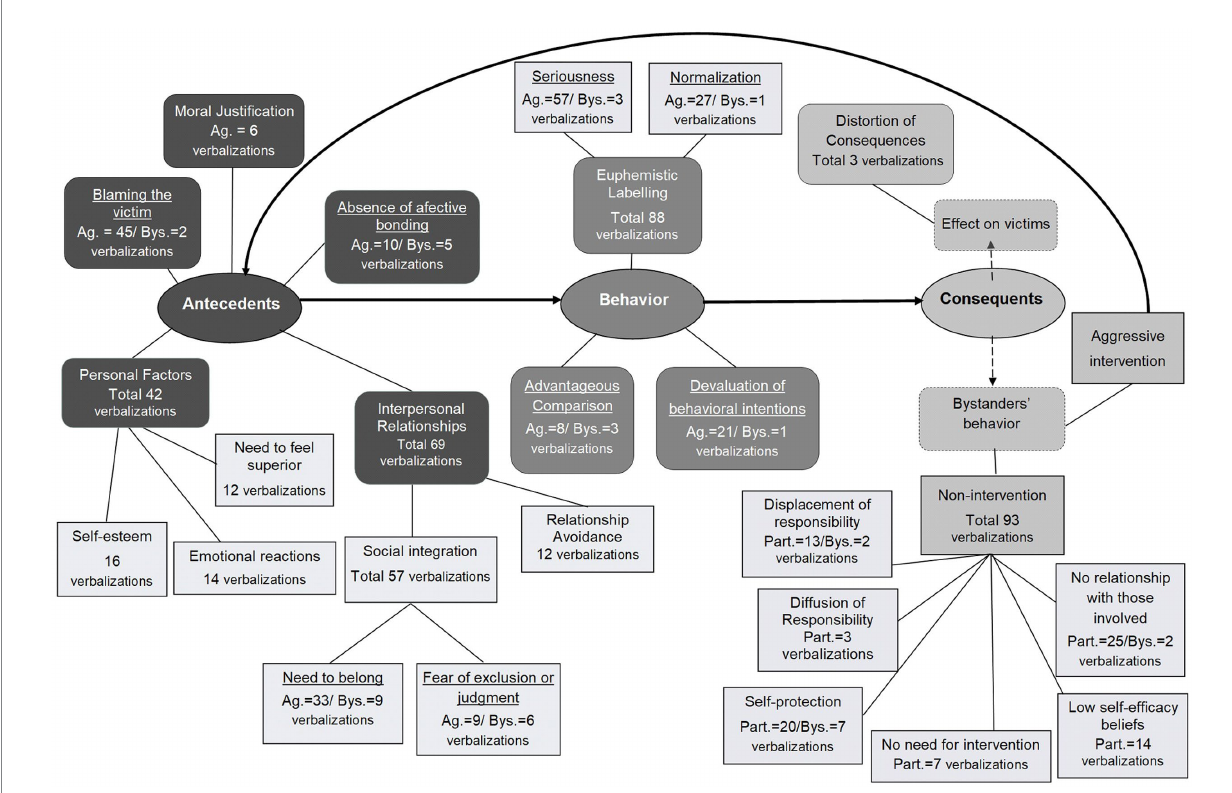
FIGURE 1 Procedural model of cyberbullying in the perspective of participants, as bystanders of the scenarios. Ag., aggressors’ behavior; Bys., bystanders’ behavior; Part., participants’ bystanders behavior in the scenarios. From Francisco et al.